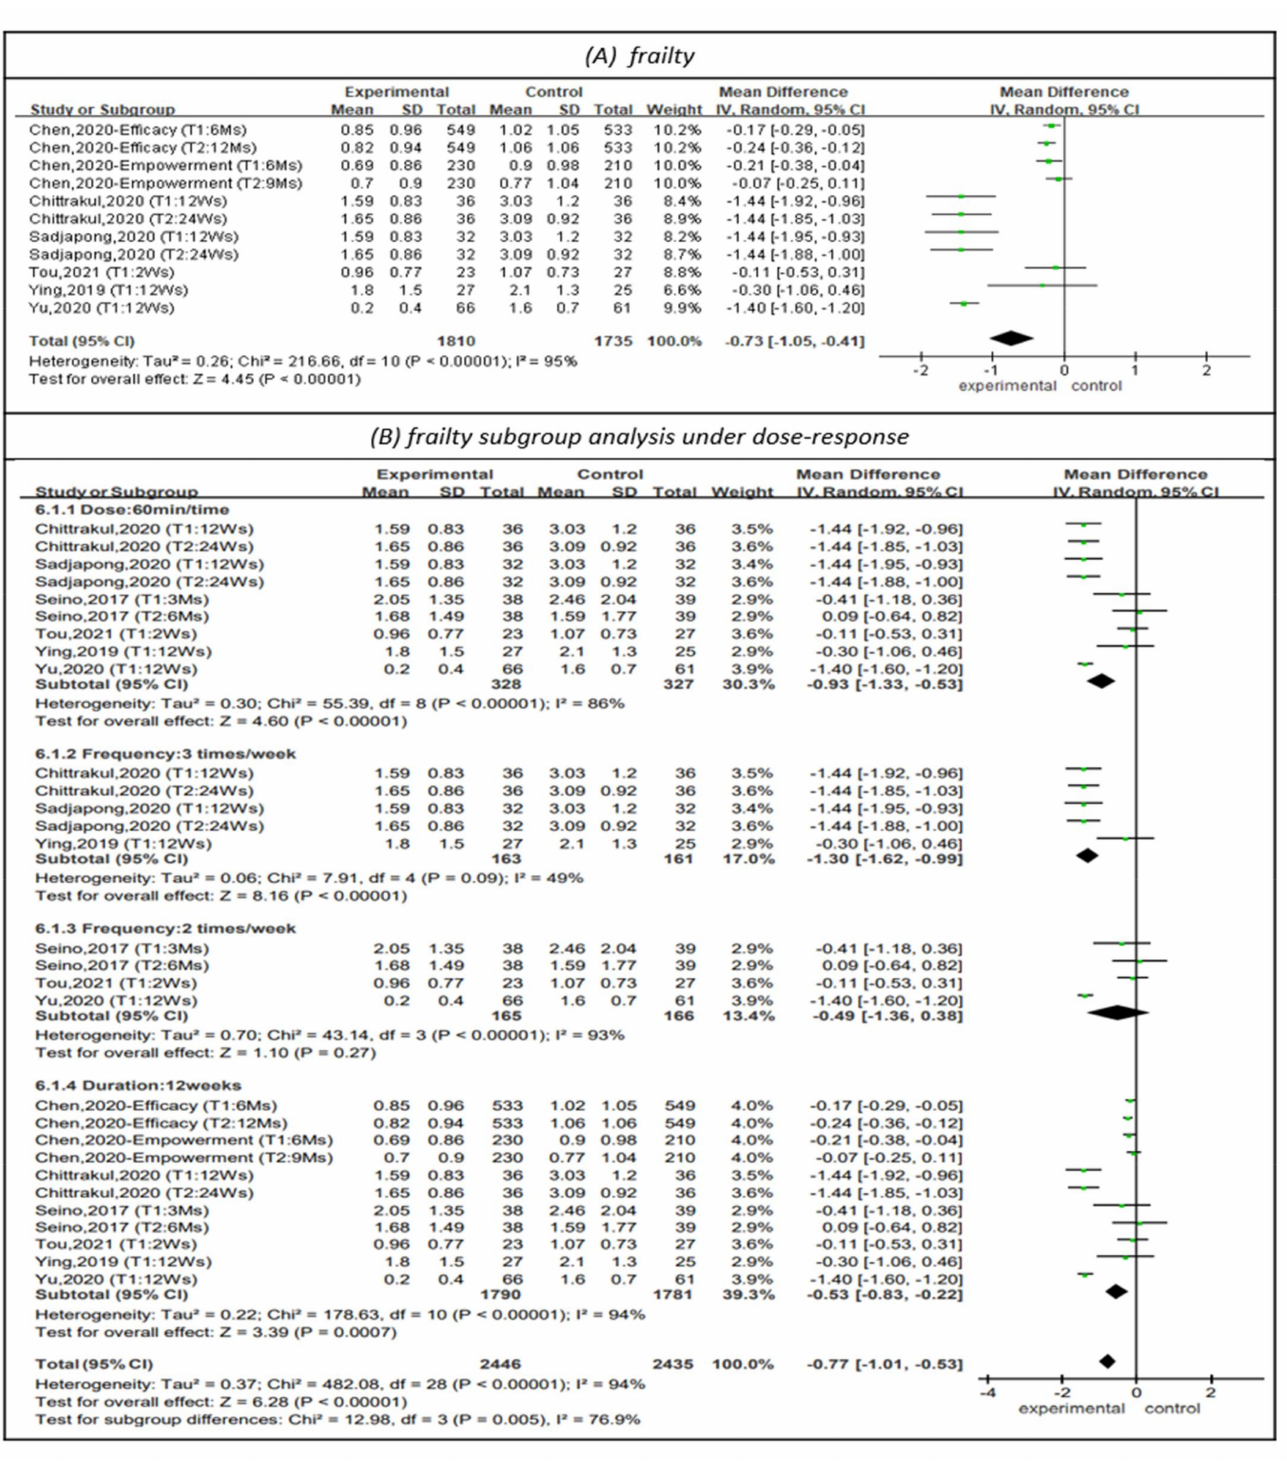
Figure 3. Forest plot of effects on frailty and subgroup analysis for dose-response. The size of the green square represents the weight of the study in the meta-analysis. The rhombus represents the combined OR. OR = odds